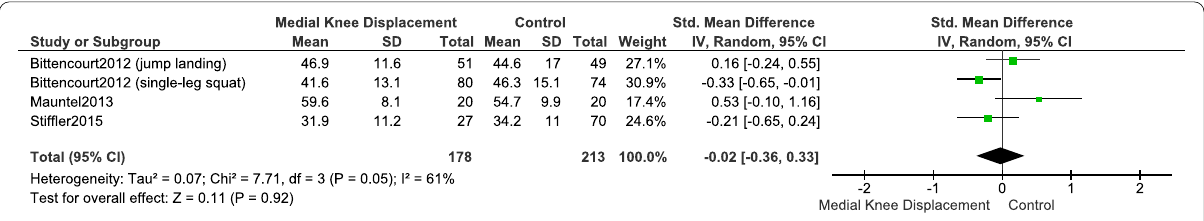
Fig. 5 Meta-analysis results detailing the association between internal rotation ROM and 2D frontal plane knee projection angle